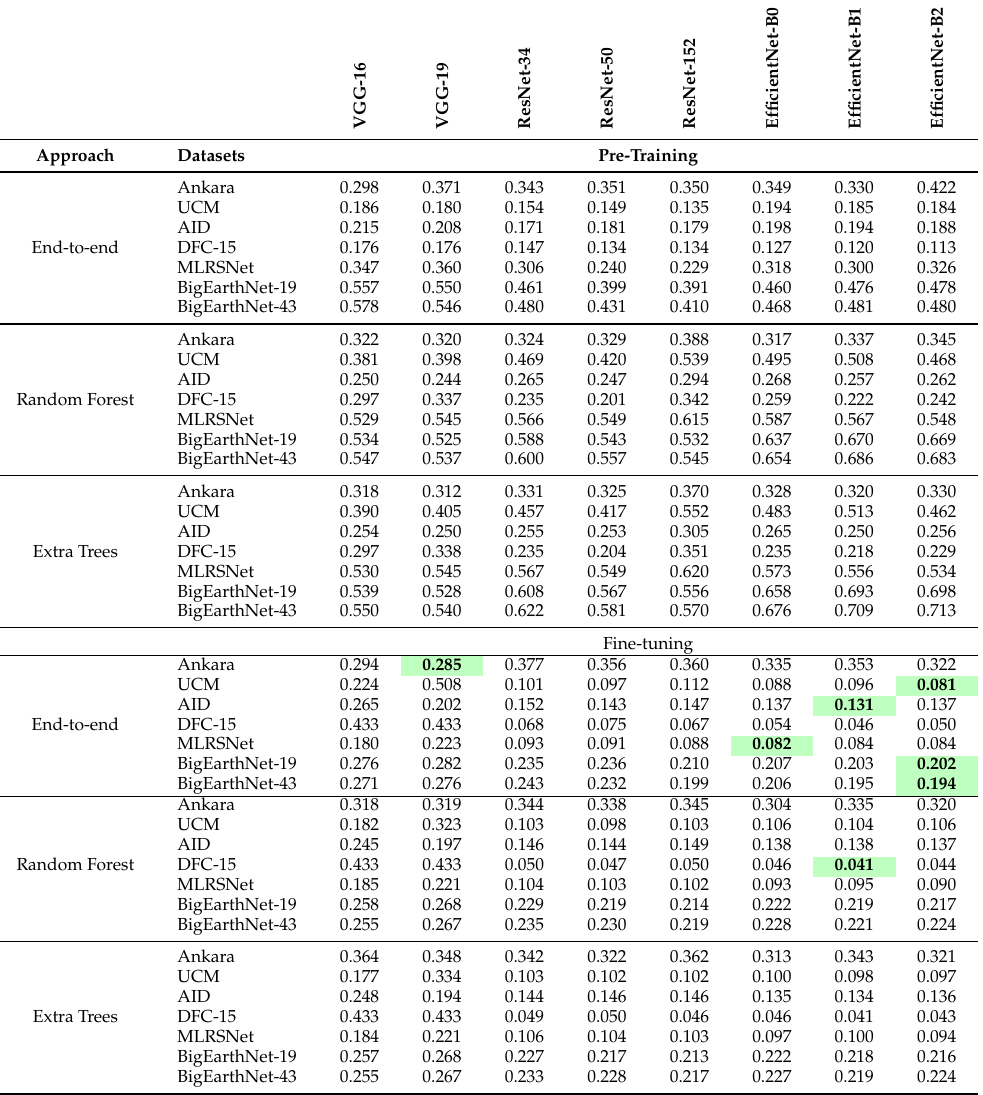
Table A1. The performance in terms of ranking loss measure of fine-tuning and pre-training feature learning approaches with different network architectures and different MLC approaches. The best performing network architecture for each dataset is highlighted with